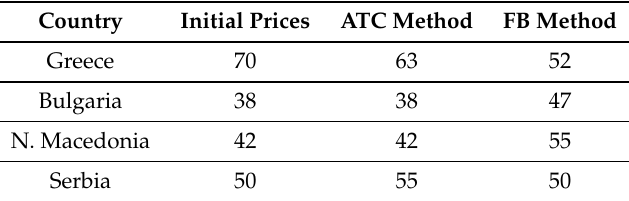
Table 6. Market prices for the 4 countries.